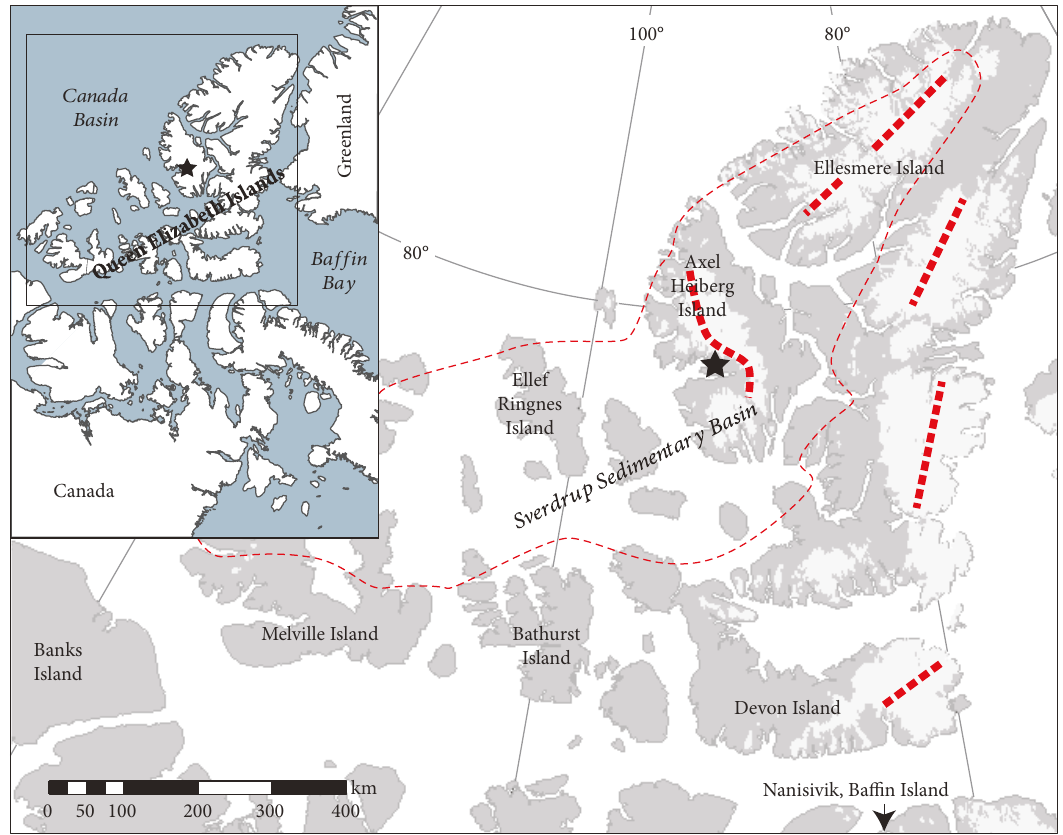
Figure 1: Location map of the White Glacier site (star) in Axel Heiberg Island, Queen Elizabeth Islands, Canadian Arctic Archipelago. Ice fi elds are light grey, generally capping 1500 – 2000m high mountains (dotted lines). The dashed line outlines the Sverdrup Basin with a thickness of up to 12km of Paleozoic to Paleogene sedimentary and volcanic rocks, including Carboniferous salt beds at depth and diapiric salt-anhydrite-gypsum structures that reach the